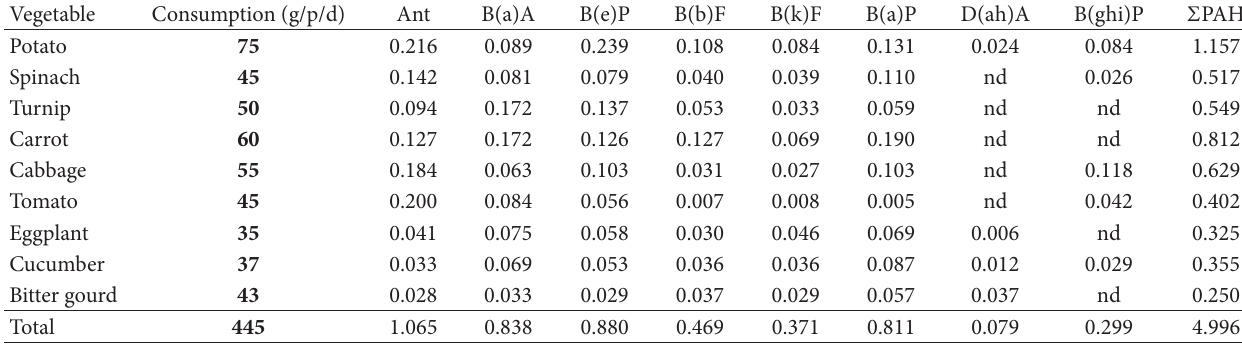
T 3: Average consumption of vegetables versus potential exposure of PAHs (